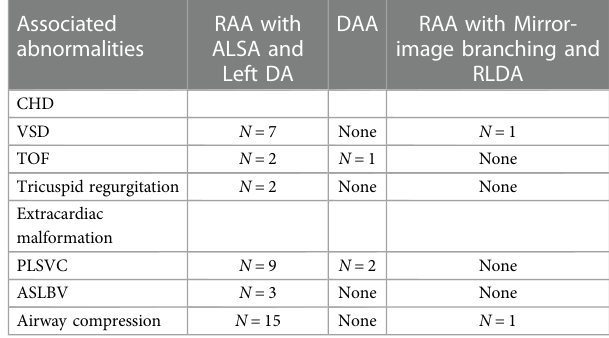
TABLE 3 The tabular summaries of associated CHDs, extracardiac malformation, and airway compression. Associated